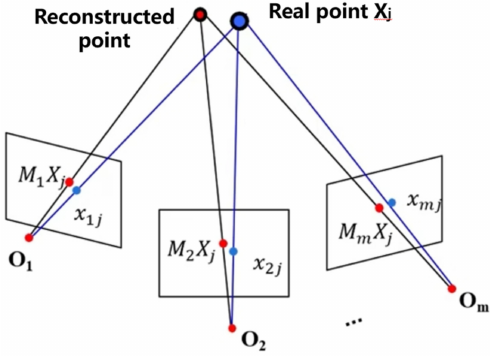
Figure 4. BA optimization decomposition. Table 1. BA optimization and Pose refinement data